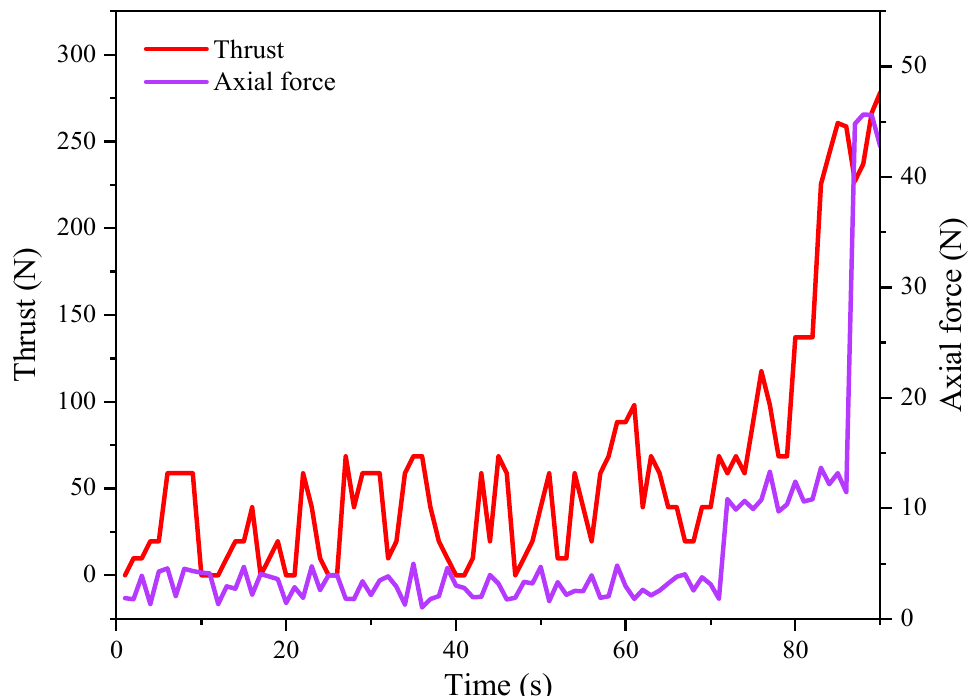
Figure 4. Thrust to sliding body and axial tension within anchor cable plotted against time. Thrust was the force applied to the moving part of the shear box measured with a mechanical transducer. The experiment process was controlled by displacement and thrust showed constant in the first part of the experiment and increased at a certain stage.